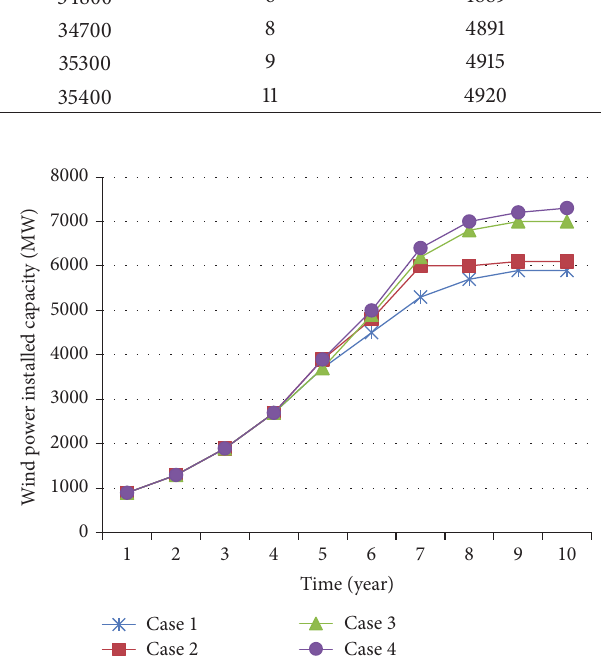
Figure 8: Wind power installation distribution within the planning period in 4